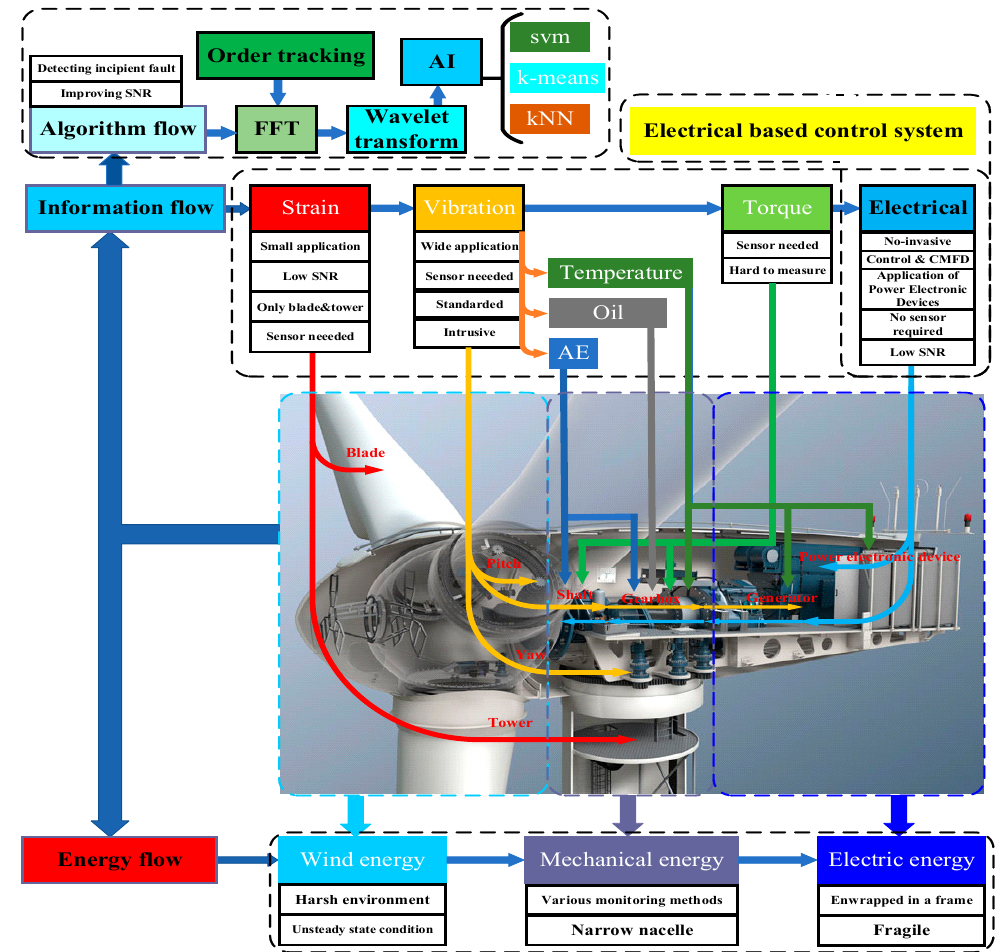
Figure 10. WT causal chains and monitoring components.